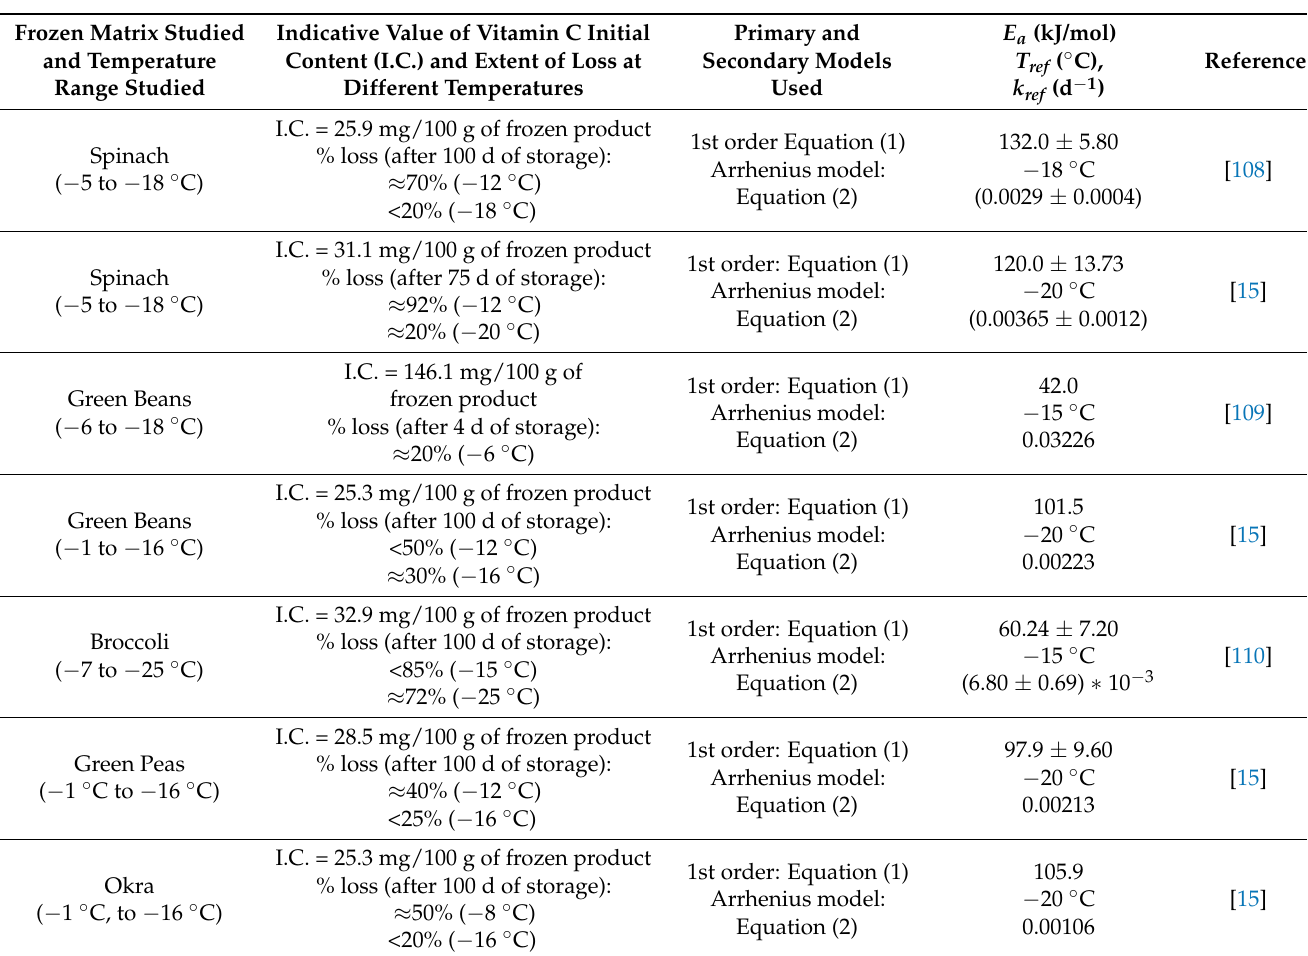
Table 2. Overview of the kinetic methodology applied and the main results obtained for the storage effect for various frozen fruits and vegetables. Frozen Matrix